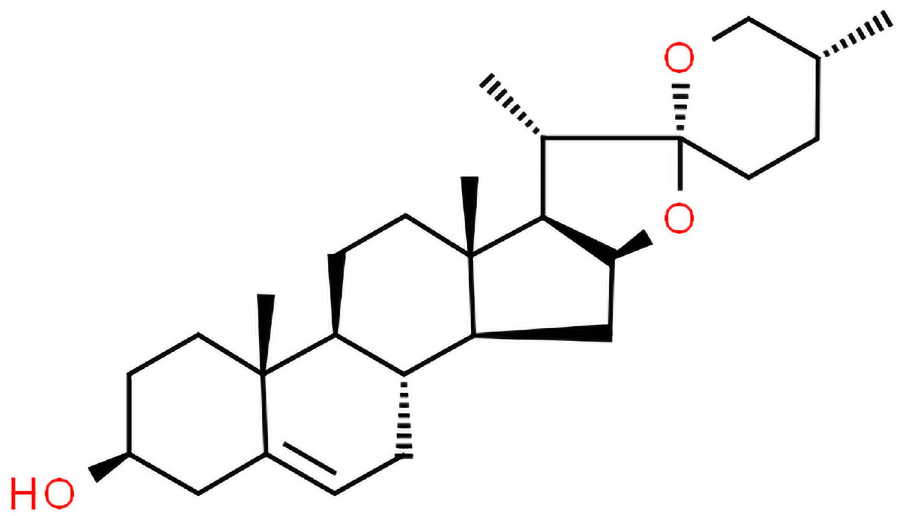
Fig 1. Chemical structure of